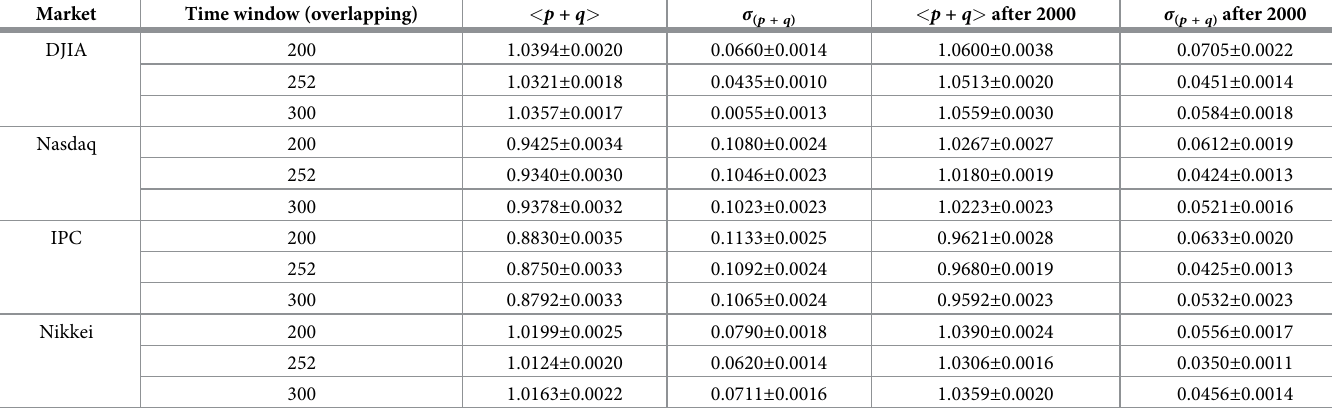
Table 10. Mean and standard deviation of p + q distributions, where rolling, overlapping time frames of 200, 252 and 300 trading days were set up and shifted each 10 days. Observed p + q mean values are very close to the value of 1 for Nikkei and DJIA and despite non stationarity, are also close to 1 for Nasdaq and IPC markets. Restricting our analysis to dates thereafter year 1999, clearly p + q values are even nearest to the value of 1 for all markets.